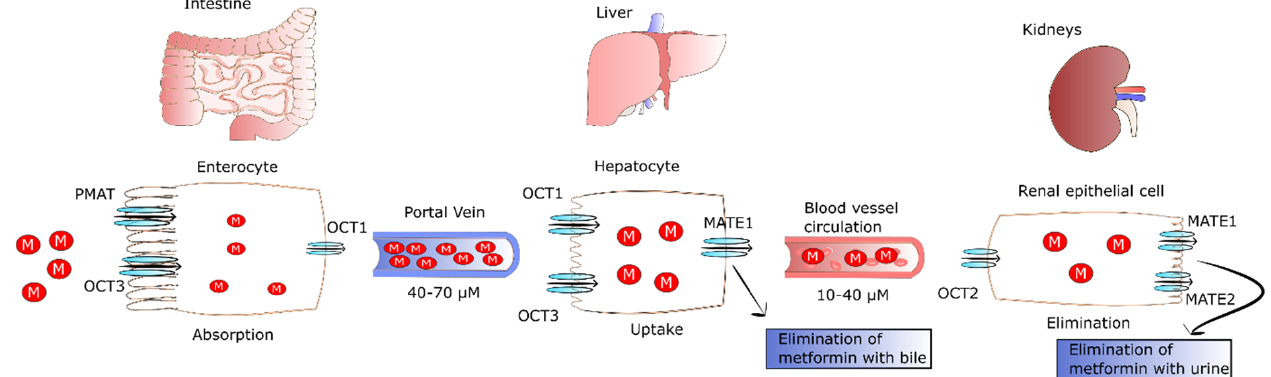
Figure 1. The fate of metformin in the human body. After oral ingestion, 50% of metformin is absorbed by passive diffusion, and the rest of the drug is transported by facilitated diffusion via PMAT and OCT1 transporters in intestinal enterocytes. Then, the drug leaves enterocytes via OCT1 and is transported to the liver via the portal vein where it reaches concentrations of 40–70 µM. Metformin enters the liver via OCT1 and OCT3 where it inhibits gluconeogenesis. The drug is not metabolized by the liver, but MATE1 expressed in hepatocytes participates in elimination of unchanged drug with the bile or in its transport with the blood to kidney. Then, metformin enters renal epithelial cells via OCT2. Next, the drug is secreted by renal MATE1 and MATE2 in unchanged form and eliminated with urine. Abbreviations: M, metformin; PMAT, plasma membrane monoamine transporter; OCT1, organic cation transporter 1; OCT2, organic cation transporter 2; OCT3, organic cation transporter 3; MATE 1, multidrug and toxin extrusion protein 1; MATE2, multidrug and toxin extrusion protein